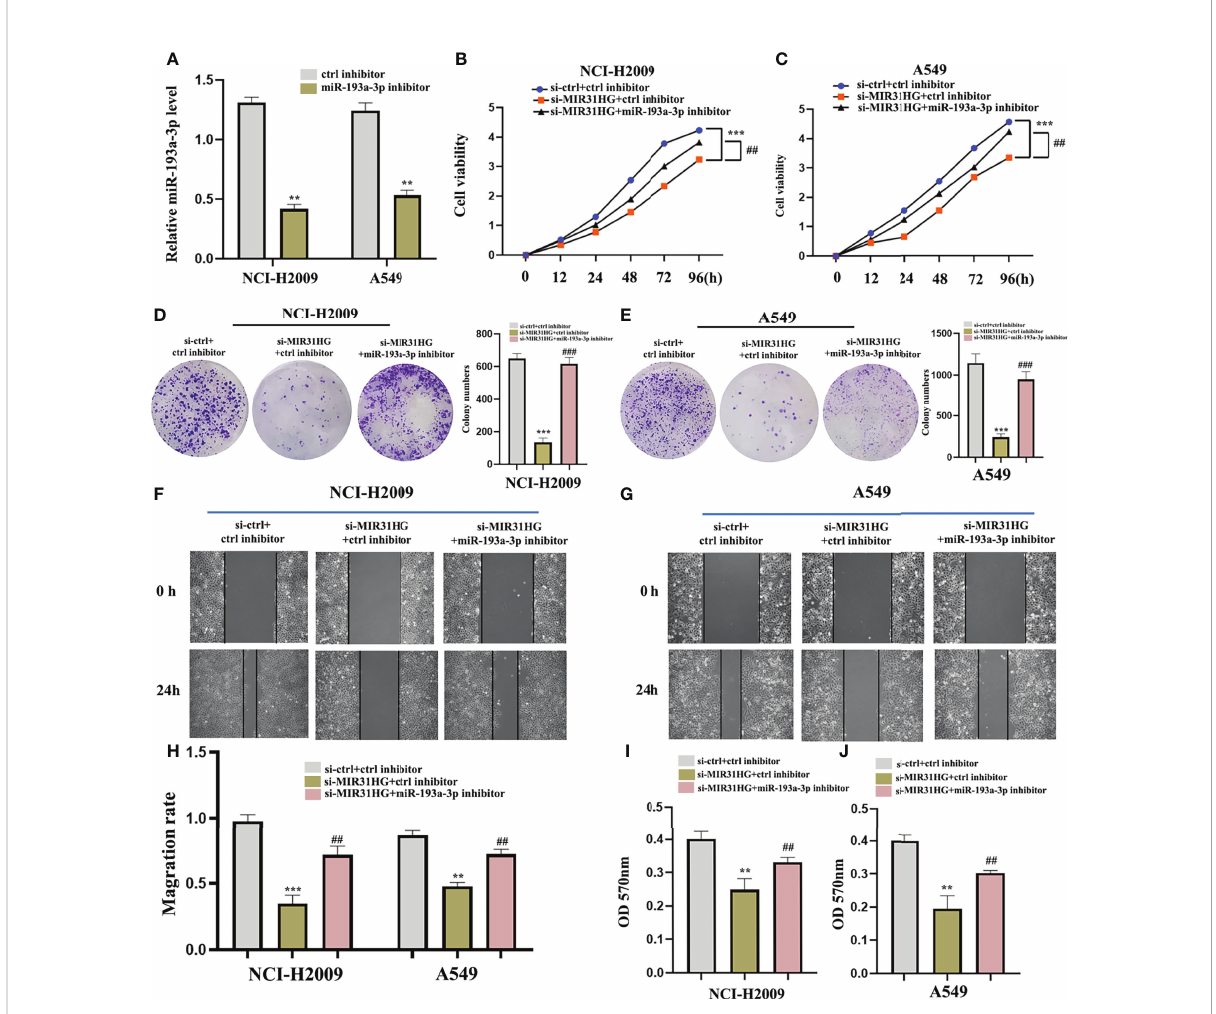
FIGURE 10 miR-193a-3p reversed the lncRNA MIR31HG knockdown effects on lung adenocarcinoma cells. (A) The expression of miR-193a-3p was investigated by qRT-PCR. (B, C) The proliferation of NCI-H2009 and A549 cells were detected by CCK-8 assays. (D, E) The clone capacity of NCI-H2009 and A549 cells was identi fi ed by colony formation assay. (F-H) The migration of NCI-H2009 and A549 cells was determined by wound healing assays. (I, J) The invasion of NCI-H2009 and A549 cells was investigated by transwell assays. ** p < 0.01; *** p < 0.001 vs . ctrl inhibitor, ## p < 0.01; ### p < 0.01 vs . si-MIR31HG+miR-193a-3p